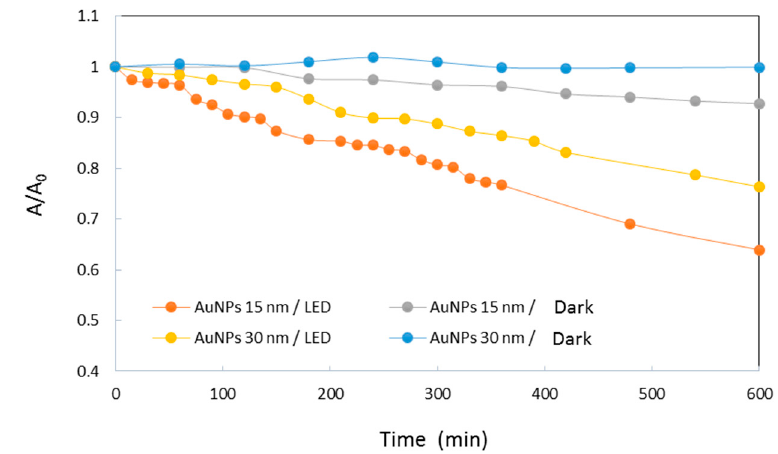
Figure 8. Kinetic traces of the normalized absorbance at 420 nm of HC-FeIII in deaerated aqueous solutions containing 5 × 10 − 4 M potassium hexacyanoferrate in the presence of 15 nm or 30 nm Au-NPs@citrate and in the dark or under LEDs irradiation at 520 nm.